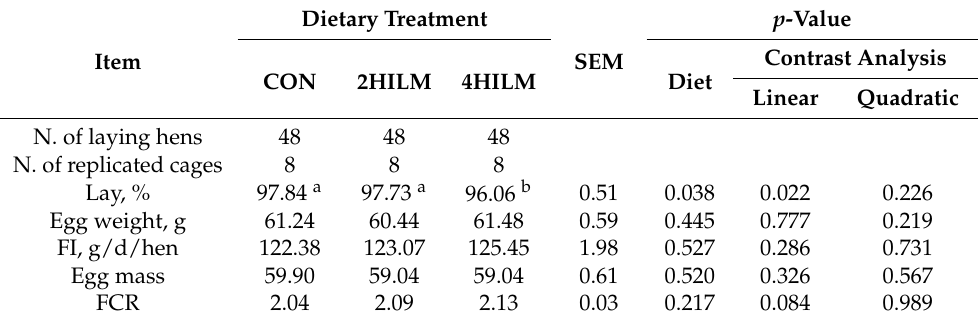
Table 3. Effect of the dietary Hermetia illucens larvae meal (HILM) inclusion level on the productive performance of laying